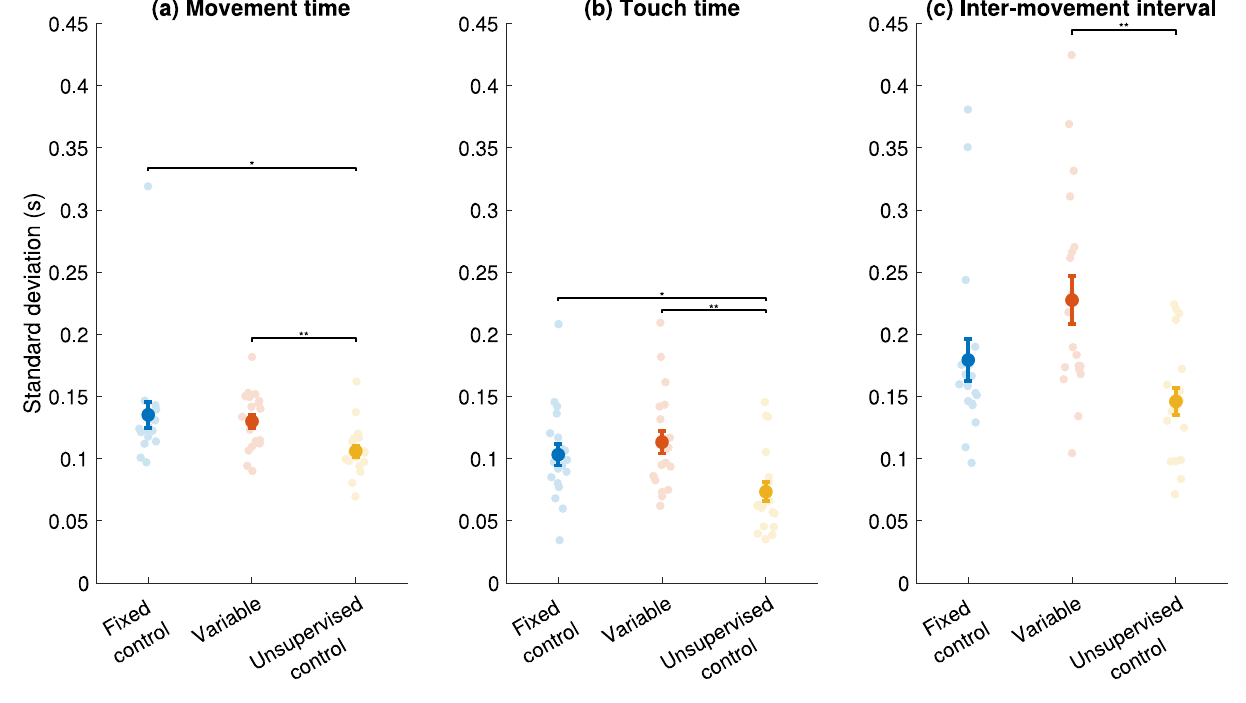
Figure 3. Differences in standard deviation across groups during training. Each panel shows a different component of the movement. The faint circles are data for all subjects, darker dots are the mean, error bars are the standard error for each group. The black bars indicate significant between-group differences. *p ≤ 0.05, **p ≤ 0.01. N = 19 for all groups.